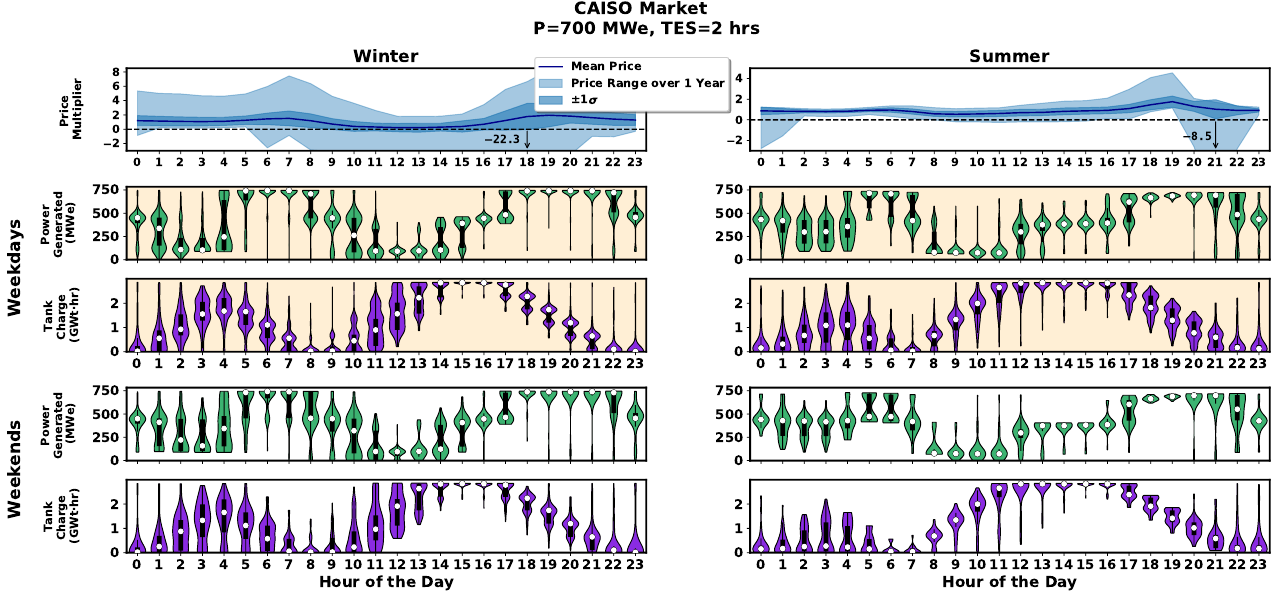
Figure 8. (Top row) Hourly ranges in normalized CAISO energy price multipliers for a full year. Mean price and standard deviation are shown in a darker shade. (Rows 2–5) Hourly violin plot distributions for a year of simulated electric power and stored energy levels. Computed for a 700 MW e turbine with 2 h of TES under normalized CAISO energy prices. Median value for each hour is shown as a white circle and the black vertical rectangle demarcates 25th and 75th percentiles. Distributions are split between winter and summer price schedules as well as weekday and weekend